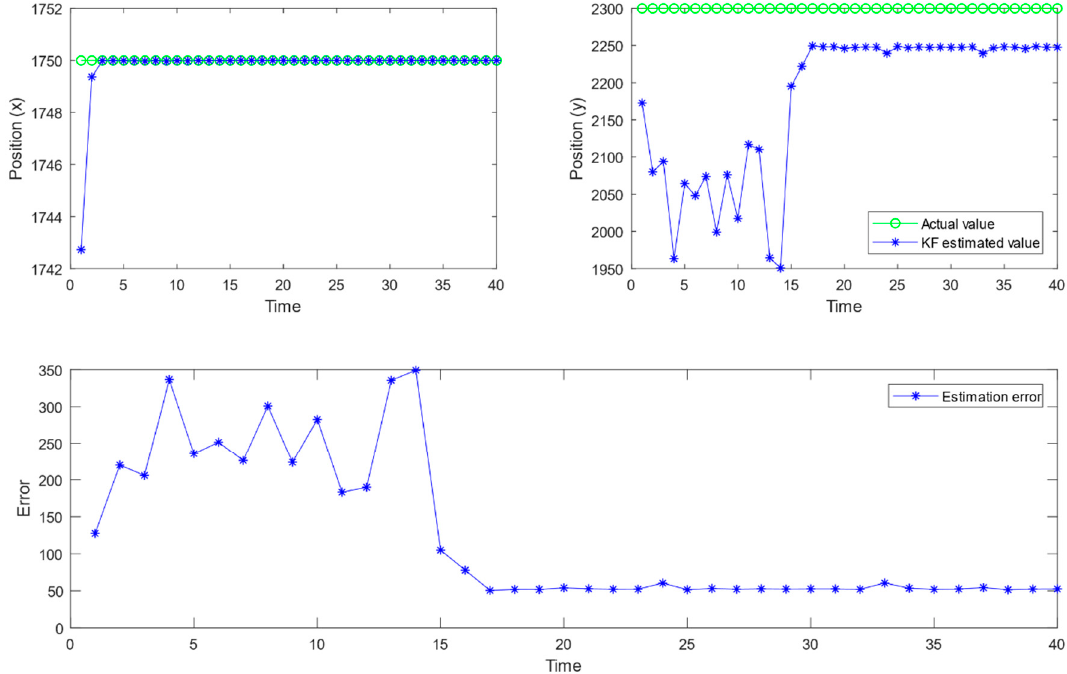
Figure 2. Graphical output of the implementation of Algorithm 3. (The error is measured in the units of the used coordinate system, with 50 units corresponding to the distance of 1 m).